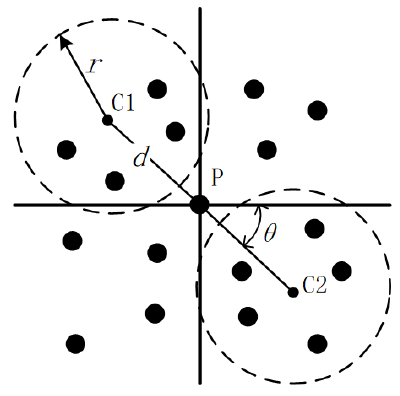
Figure 4. Non-maximum suppression applied to point clouds.